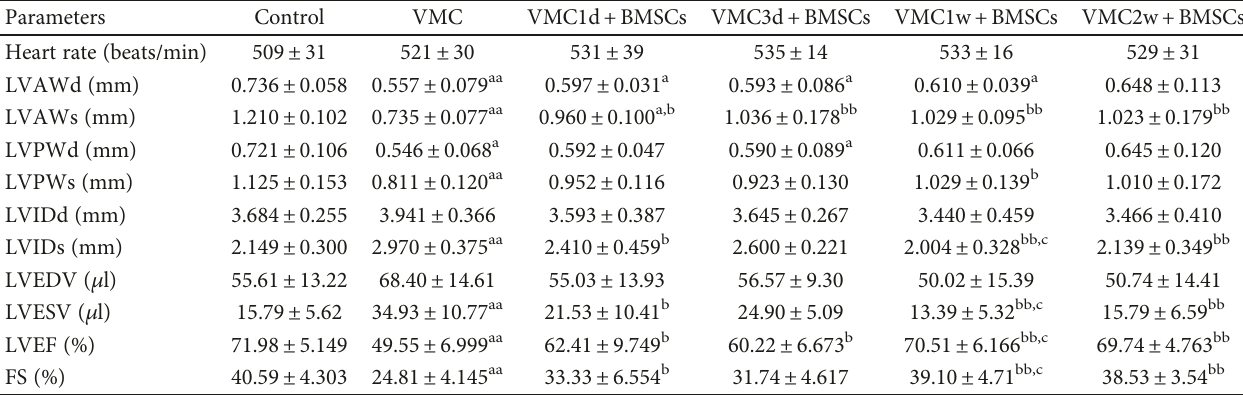
Table 1: Echocardiography on the 28th day after CVB3 inoculation. n = 8 for each